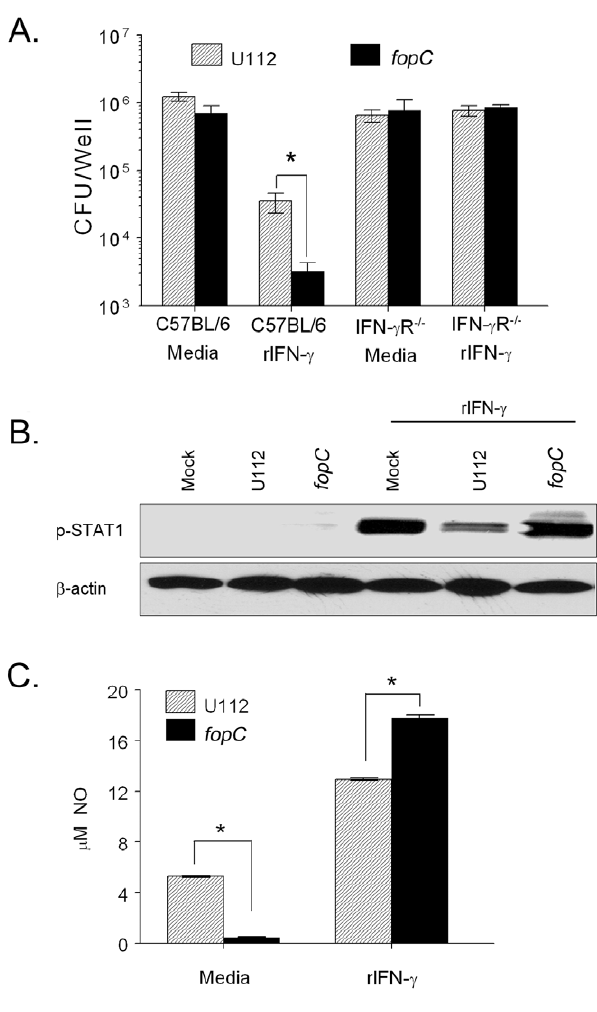
Figure 5. IFN- c mediated inhibition of intramacrophage F. novicida replication. (A) Bone marrow derived primary macrophages (2 6 10 5 /well) from C57BL/6 or IFN- c R 2 / 2 mice were infected (10 MOI) with wildtype U112 or fopC mutant in the presence or absence of 1 ng/ ml rIFN- c and numbers of viable bacteria at 24 h determined by lysing the macrophages and dilution plating. Results are expressed as the averages of values for three wells. (B) C57BL/6 macrophages (10 6 /well) were infected (10 MOI) with U112 or fopC strain in the presence or absence of rIFN- c (1 ng/ml) for 3 h. Protein-matched lysates from 3 h cultures with and without added rIFN- c were resolved by SDS PAGE and analyzed by Western blotting with phosphotyrosine-STAT1 antibody or actin antibody. (C) Nitric oxide concentration was determined in the 24 h supernatants using Griess reagent. Differences between NO levels of U112 and fopC strains are significant with p values , 0.001 as represented by * in the figure. (Representative of three experiments.)